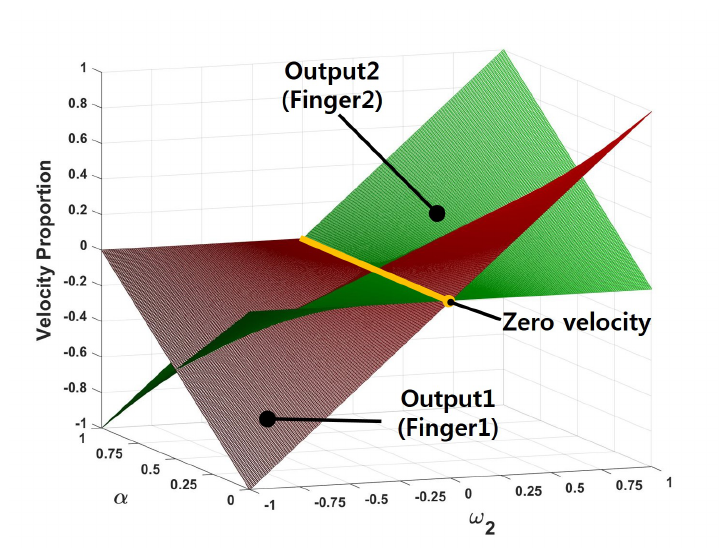
Figure 7. Simulation of velocity ratio for the differential gear